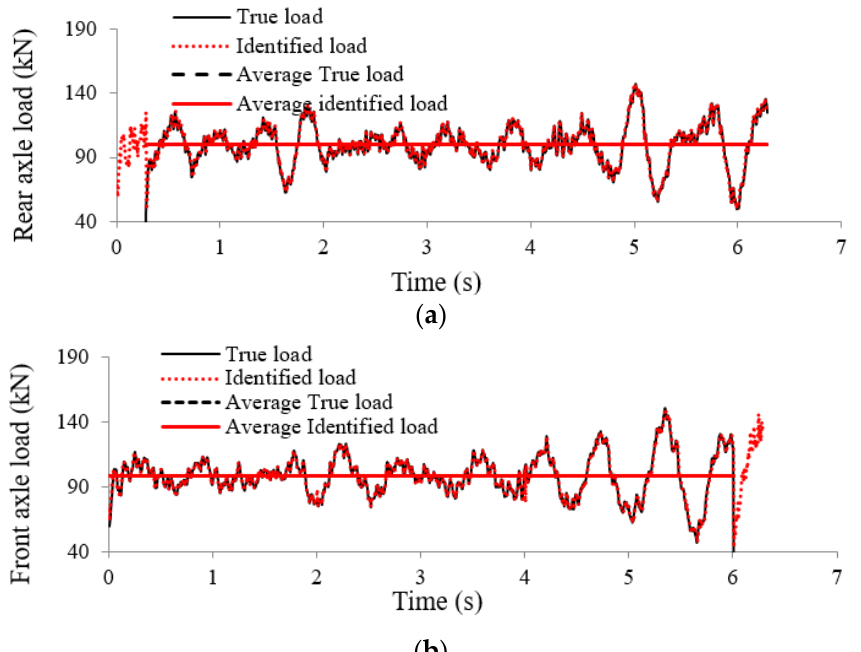
Figure 9. Identified loads at road roughness level B, speed 15 m/s and 0% noise: ( a ) rear axle load identification, ( b ) front axle load identification.